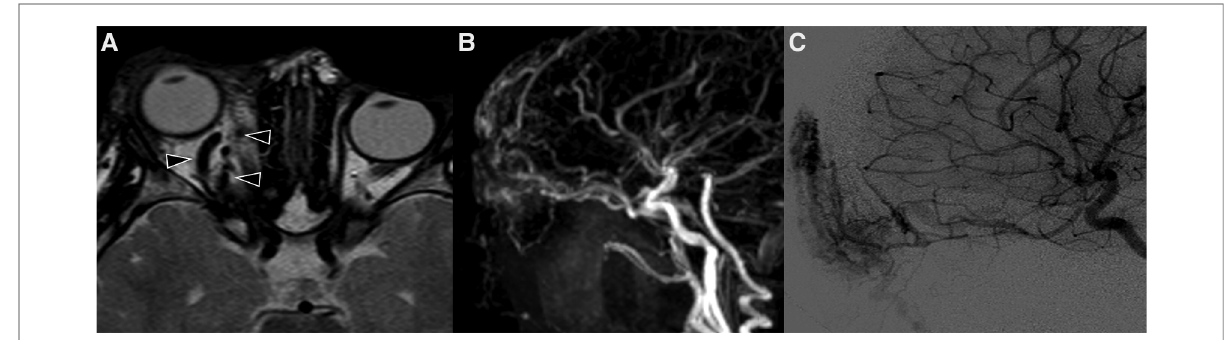
FIGURE 11 Mr and DSA of a 2-year-old boy referred for follow-up of an orbital “ hemangioma ” treated with propranolol and worsening of proptosis. Axial T2 TSE sequence ( A ) shows markedly dilated and tortuous vessels (arrowheads) in the extra- and intra-conal compartments of the right orbit without a discrete parenchymatous component, raising the suspicion of an AVM. MR angiography revealed a tangle of vessels with a small nidus and early venous drainage ( B ). The fi ndings were subsequently con fi rmed at DSA ( C ).